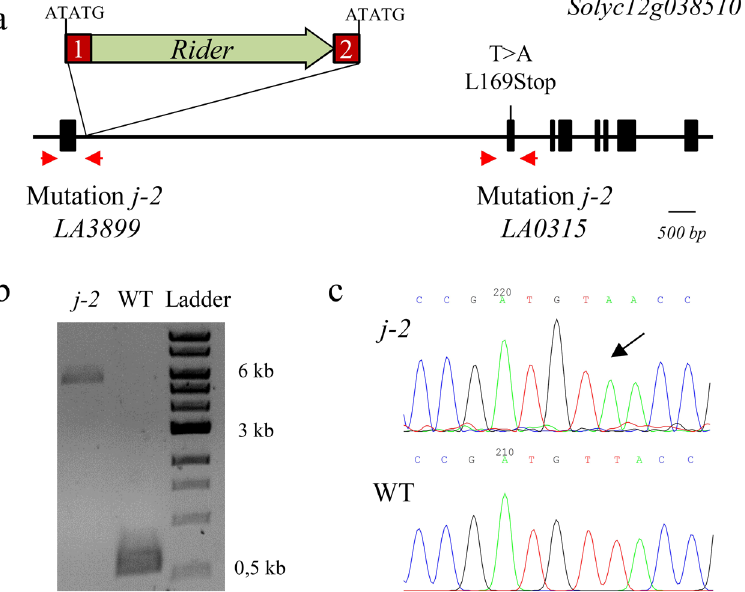
Figure 4. Mutations found in the j-2 mutants (LA0315 and LA3899). (a ) Insertion of a Transposable Element ( Rider ) in LA3899 and base substitution introducing a stop codon in LA0315. ( b ) Size of the fragments (5460- and 587-bp) amplified between the first exon and the first intron in j-2 (LA3899) and WT genomic DNA (compared to 1 kb DNA Ladder). The largest band was extracted and cloned in the pGEM-T Easy vector for sequencing. ( c ) Sequencing results of WT and j-2 (LA0315) PCR products amplifying the second exon of the